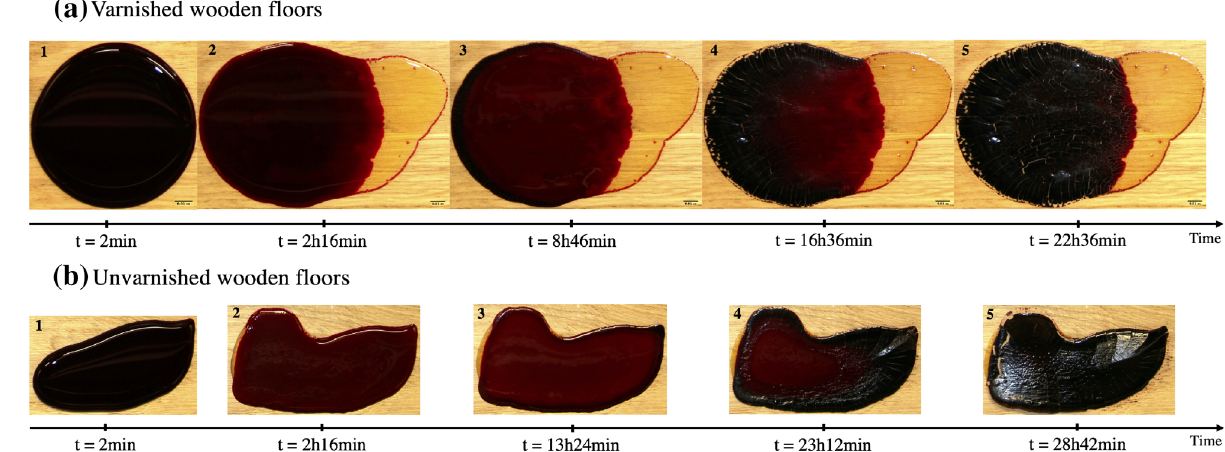
Figure 2. Time lapse of a drying pool of blood ( m i = 4.82 g , hct = 41.5% ) on ( a ) varnished and ( b ) unvarnished wooden floor at 21 ◦ C with a relative humidity of 60% . Serum separation and the five drying stages are shown.